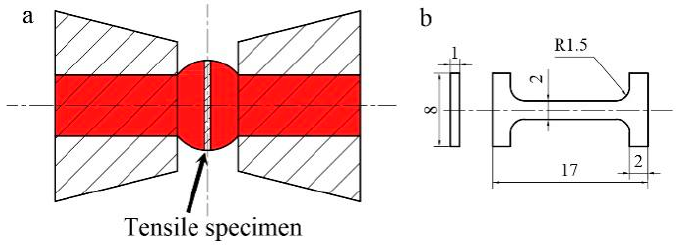
Figure 2. ( a ) Sampling points of a micro-tensile sample, ( b ) cross-section of the sample. The surface underneath the thermocouple was polished and etched in a 4 vol.% Nital solution and observed using an axiover-200mat optical microscope (OM). M/A constitu- ents were observed using the OM after etching with the Lepera reagent. The quantitative results related to the M/A constituent were obtained using the Image-Pro Plus software.